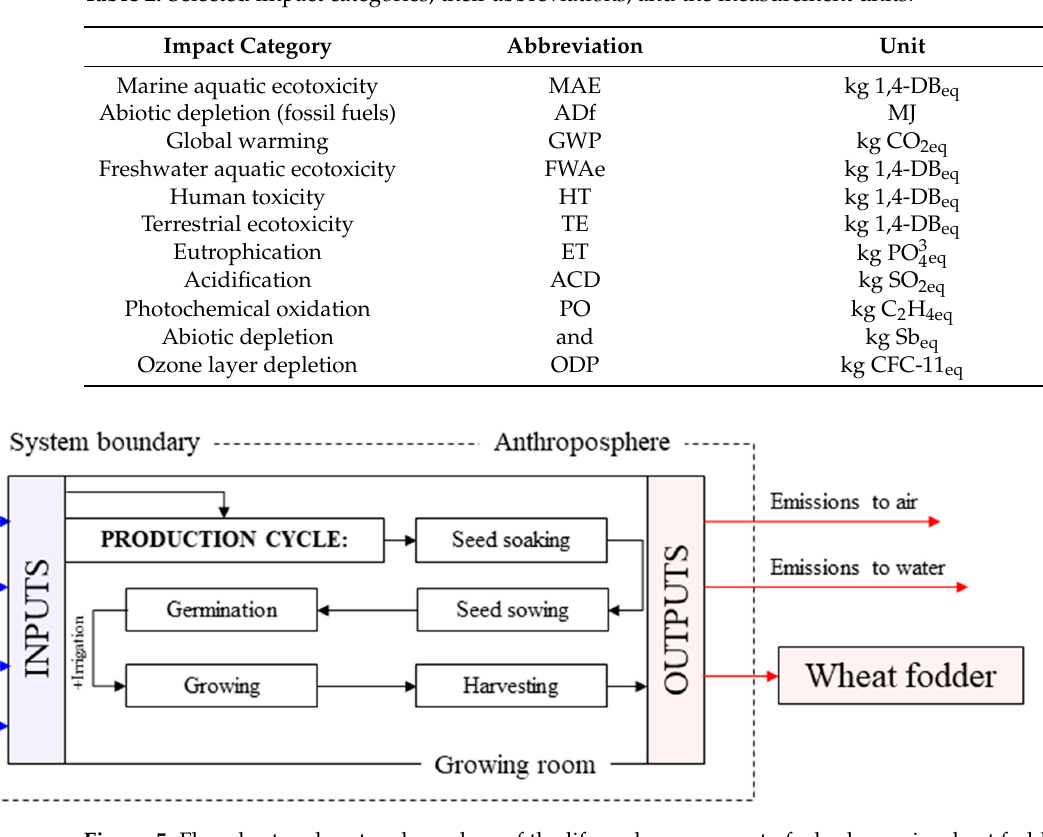
Figure 5. Flowchart and system boundary of the life cycle assessment of a hydroponic wheat fodder production facility.